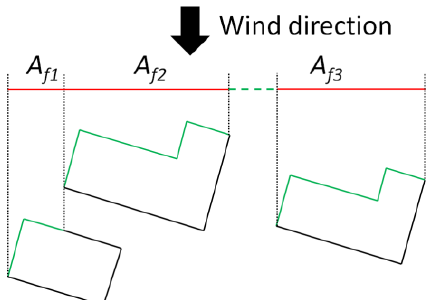
Figure 3. ‘Frontal area surface’ calculations with the green lines representing building surfaces blocking the wind. The red line represents the projected frontal area surface of the buildings considered in the calculation of the ‘frontal area index’. The dashed green line represents the unblocked part of the buffer diameter.